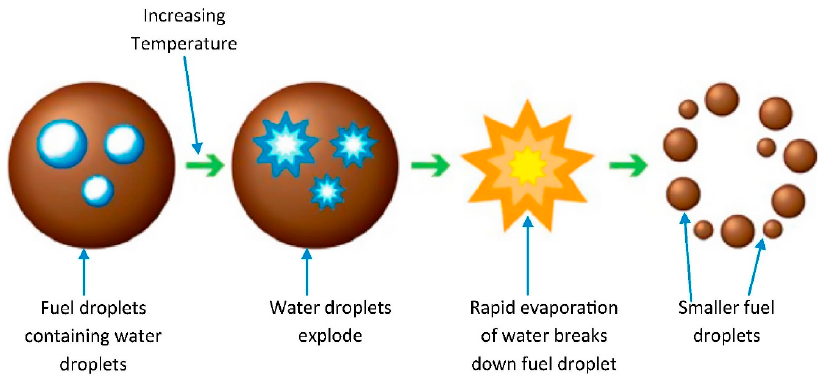
Figure 1. Mechanism of micro-explosion phenomenon [22].